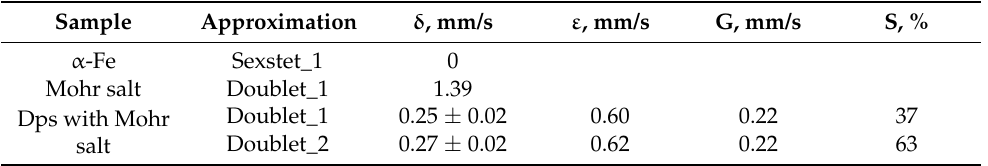
Table 1. The values of hyperfine spectrum parameters for Mohr salt and DPS protein. Sample